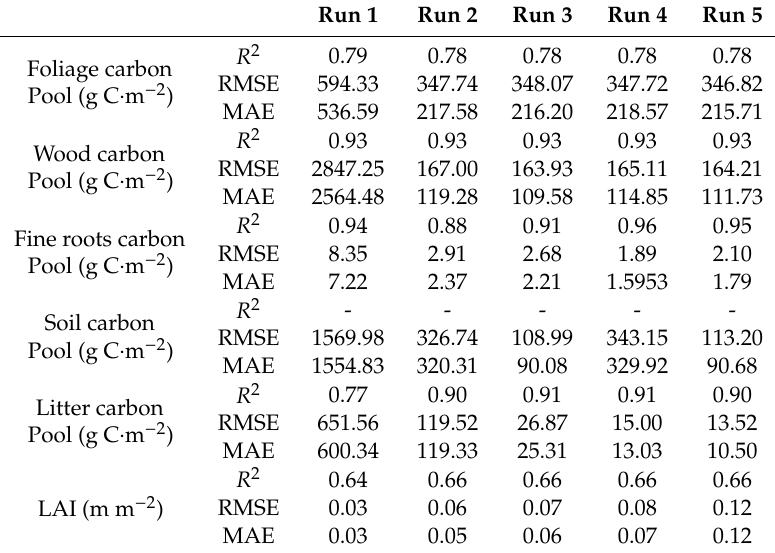
Table 3. Fit between the modeled and observed values for six variables at the Huitong subtropical Chinese fir